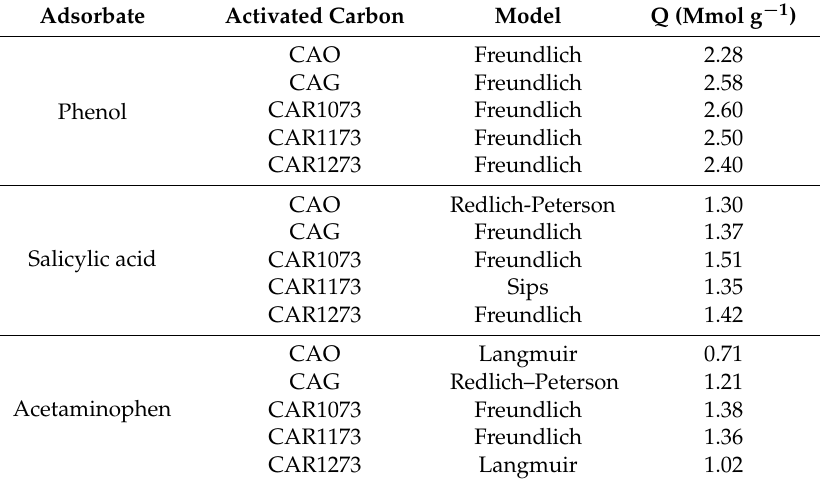
Table 13. Adsorption capacities calculated with Freundlich, Langmuir, Redlich-Peterson, and Sips models for the adsorption of phenol, acetaminophen, salicylic acid, and methylparaben on the activated